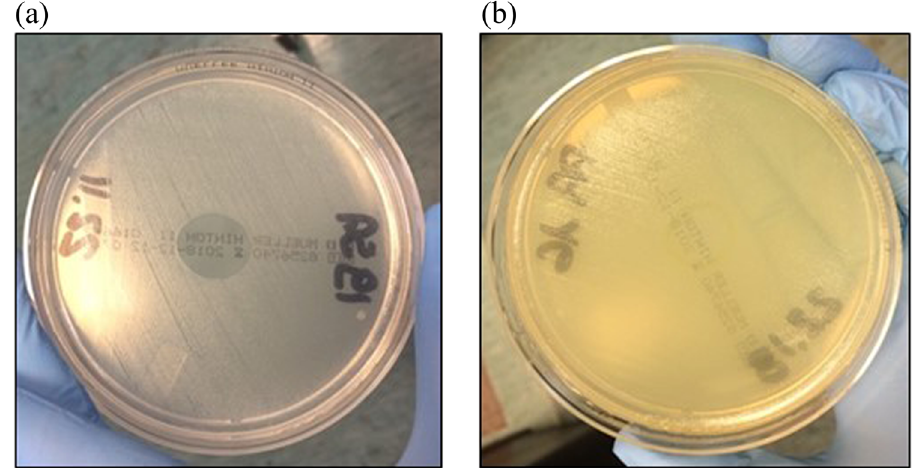
Figure 1: Culture of multidrug resistant Pseudomonas aeruginosa. ( a ) Bacterial culture after 6 h. An inhibition zone was observed at this time point. ( b ) Bacterial culture after 8 h. A recolonization in the area where the ozonated solution had been deposited was observed after 8 h.